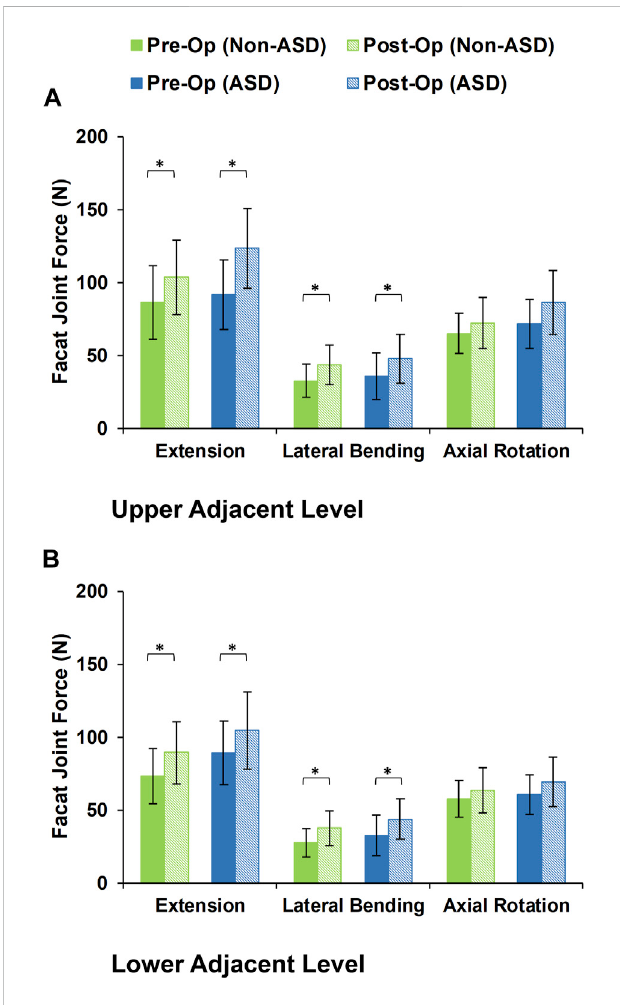
FIGURE 7 Disc height loss and fl uid loss for post-operative non-ASD and ASD group FE models for the (A) upper and (B) lower adjacent